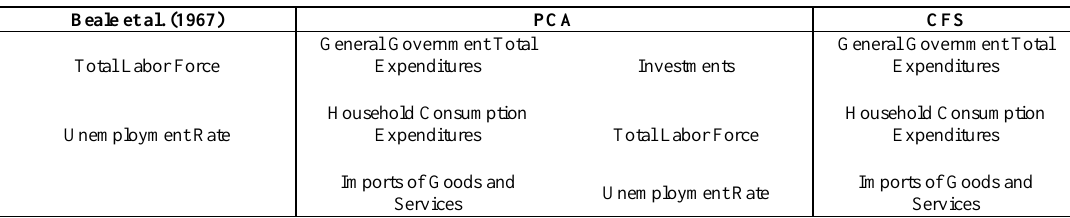
Table 3. Dimension reduction techniques